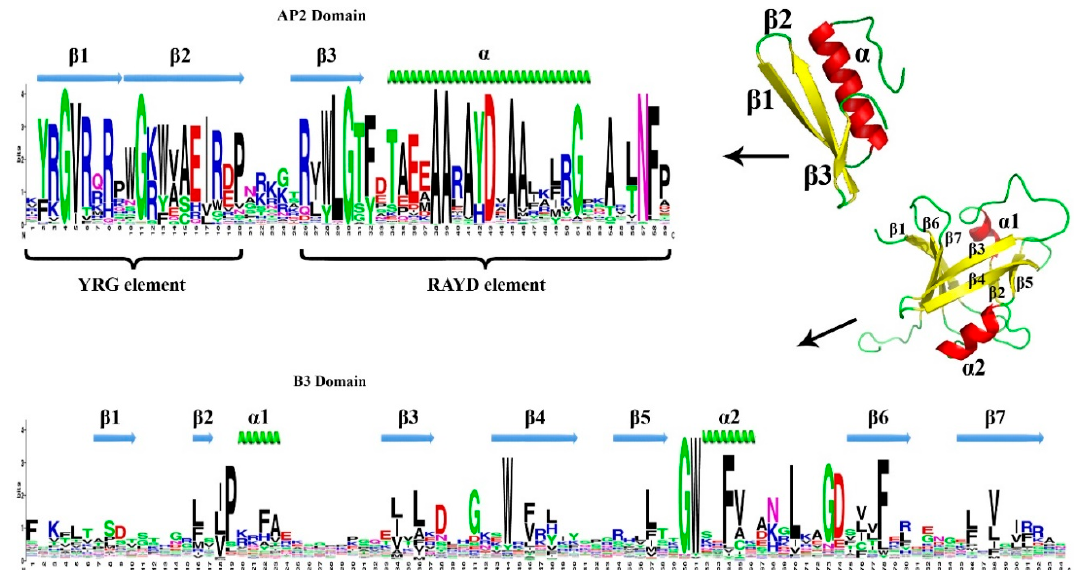
Figure 3. Molecular structure of the specific AP2 and B3 domains found in the 271 non-redundant putative TtAP2 / ERF proteins predicted from the T. turgidum genome. The abundance of each amino acid is represented by a sequence logo and the secondary and the tertiary structure of each of the domains has been predicted using the PDB database and the I-TASSER program.